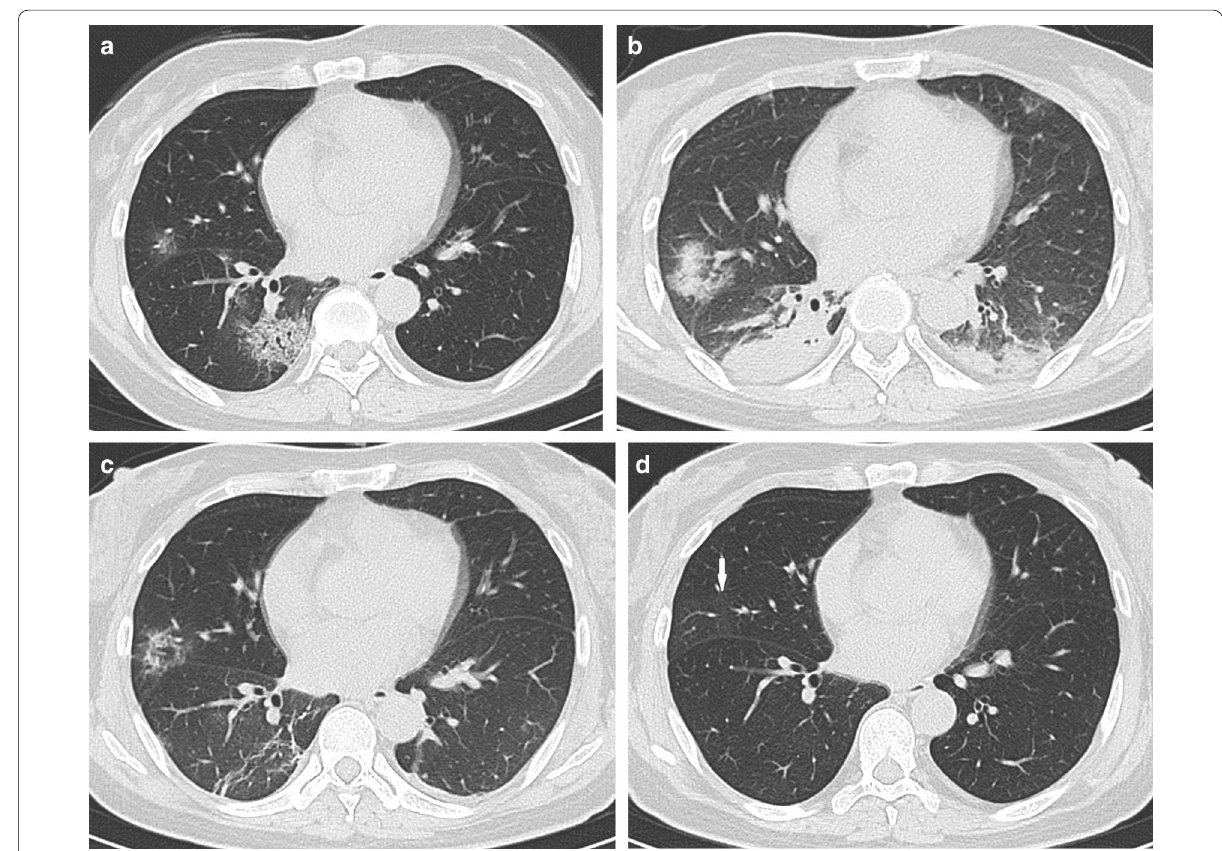
Fig. 5 Female, 55‑year‑old, COVID‑19. a The initial CT obtained 5 days from onset of symptoms shows the round ground‑glass opacity (arrow) around the subplerual area of the left lower lobe. b The peak CT obtained 9 days later shows the large patchy consolidations and pleural thickening increase much more and air bronchograms are observed. c The pre‑discharge CT obtained 8 days later shows consolidation, ground‑glass opacity, irregular lines, reticulation, and pleura thickening. d The follow‑up CT obtained 45 days later shows a few of ground‑glass opacity remained in right middle lobe